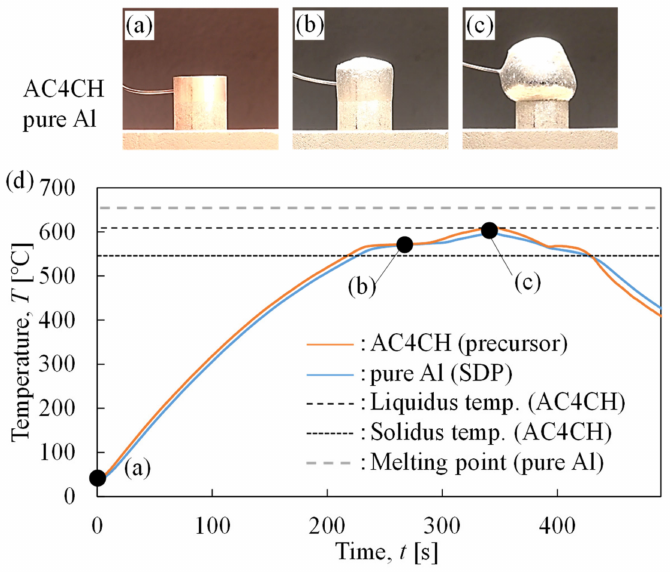
Figure 3. Foaming behavior and corresponding temperature history of AC4CH/pAl. ( a ) Begining of heat treatment. ( b ) Gradual foaming of upper AC4CH layer. ( c ) Sufficient foming of upper AC4CH layer. ( d ) Foaming time t –temperature T